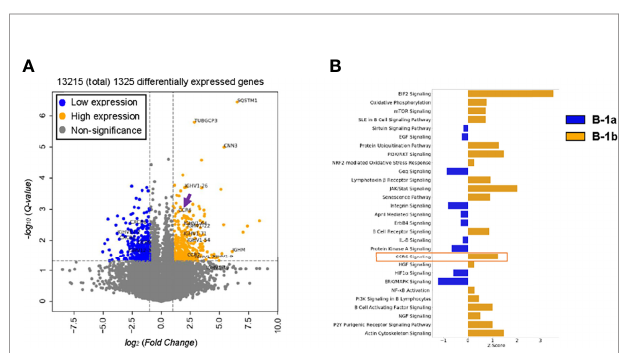
FIGURE 2 | CCR6 expression as well as CCR6 signaling are likely enriched in B-1b cells compared to B-1a cells. (A) Volcano plot of differentially expressed genes (FDR < 0.05 and log 2 (FoldChange) > or < 1) enriched in B1a (blue) and B-1b (orange) obtained from bulk RNA sequencing with n = 3 for each group. Arrow indicates CCR6 gene. (B) Canonical pathway analysis of differentially expressed genes enriched in B-1a (blue, z- activation score < 0) and B1b (orange, z-activation score > 0) obtained from bulk RNA sequencing.